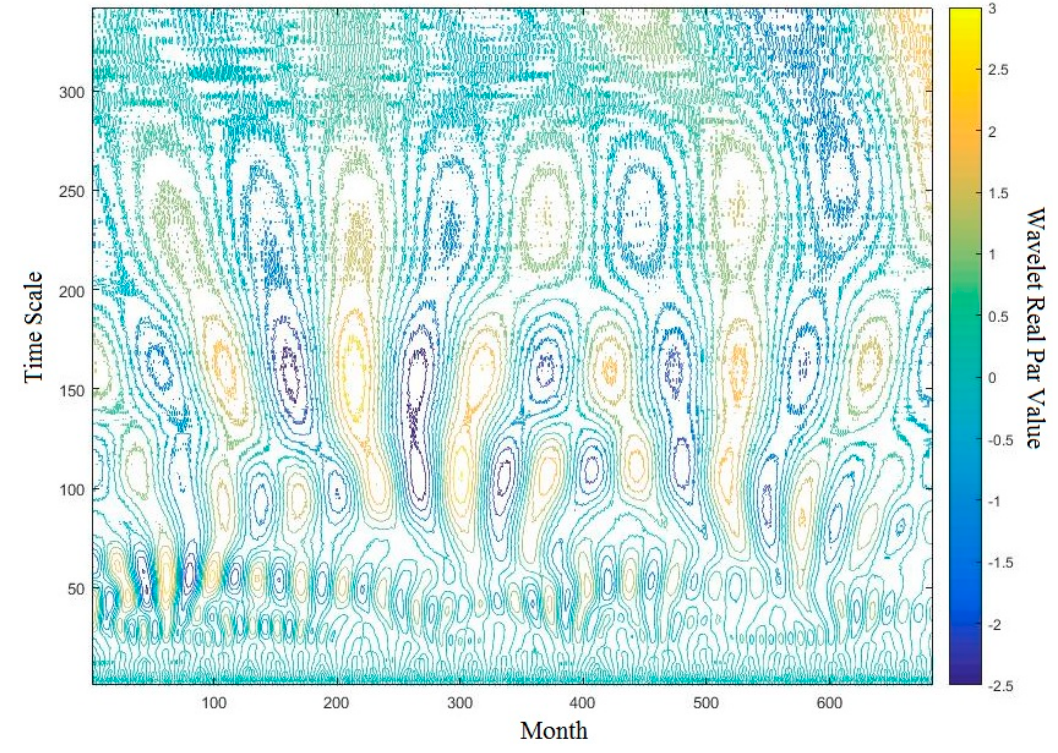
Figure 11. Real part value wavelet coefficients on SPEI12.